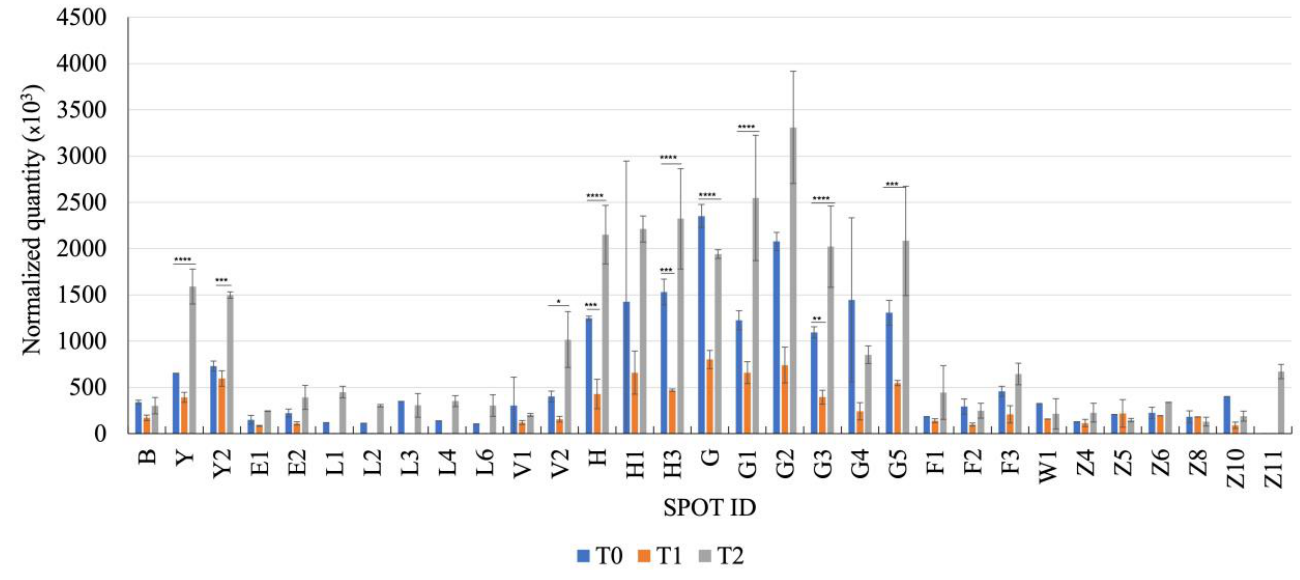
Figure 2. Quantitative analysis of each spot in the feces of dogs affected by acute uncomplicated diarrhea at T0, T1, and T2 determined by the PDquest software. Each spot was identified as indicated in Table 1. Data are shown as mean values ± SE. **** p < 0.0001, *** p < 0.001, ** p < 0.01, * p <